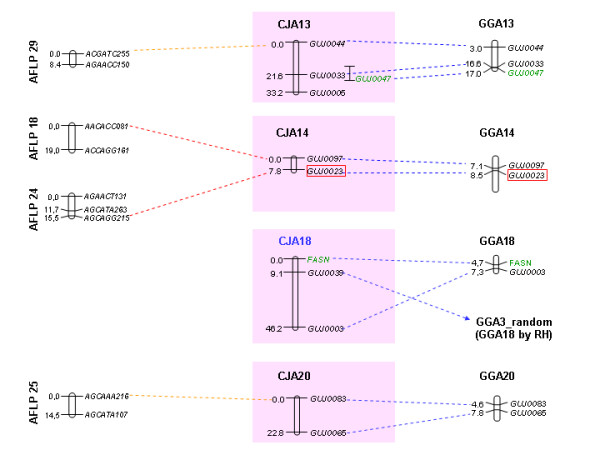
Alignments of Japanese quail microsatellite and AFLP maps and links to the assembled chicken sequence. Left: AFLP linkage groups from [14]; center: integrated microsatellite and gene map (this study); right: chicken February 2004 sequence assembly [22]. AFLP and microsatellite genetic maps are in cM and the sequence assembly is in Mb. New quail linkage groups have blue titles and new microsatellite and gene markers are in green. Genes are in boldface italic. Microsatellite markers informative in both species are in red boxes. Chicken markers have a yellow background. Quail microsatellites or genes with similarity to chicken sequence of unknown location (chrun) have a blue background. Dotted lines linking the microsatellite and the AFLP maps indicate positive results of two-point linkage between the markers, with supporting LOD scores of 3 to 6 (green), 6 to 10 (orange) or more than 10 (red).